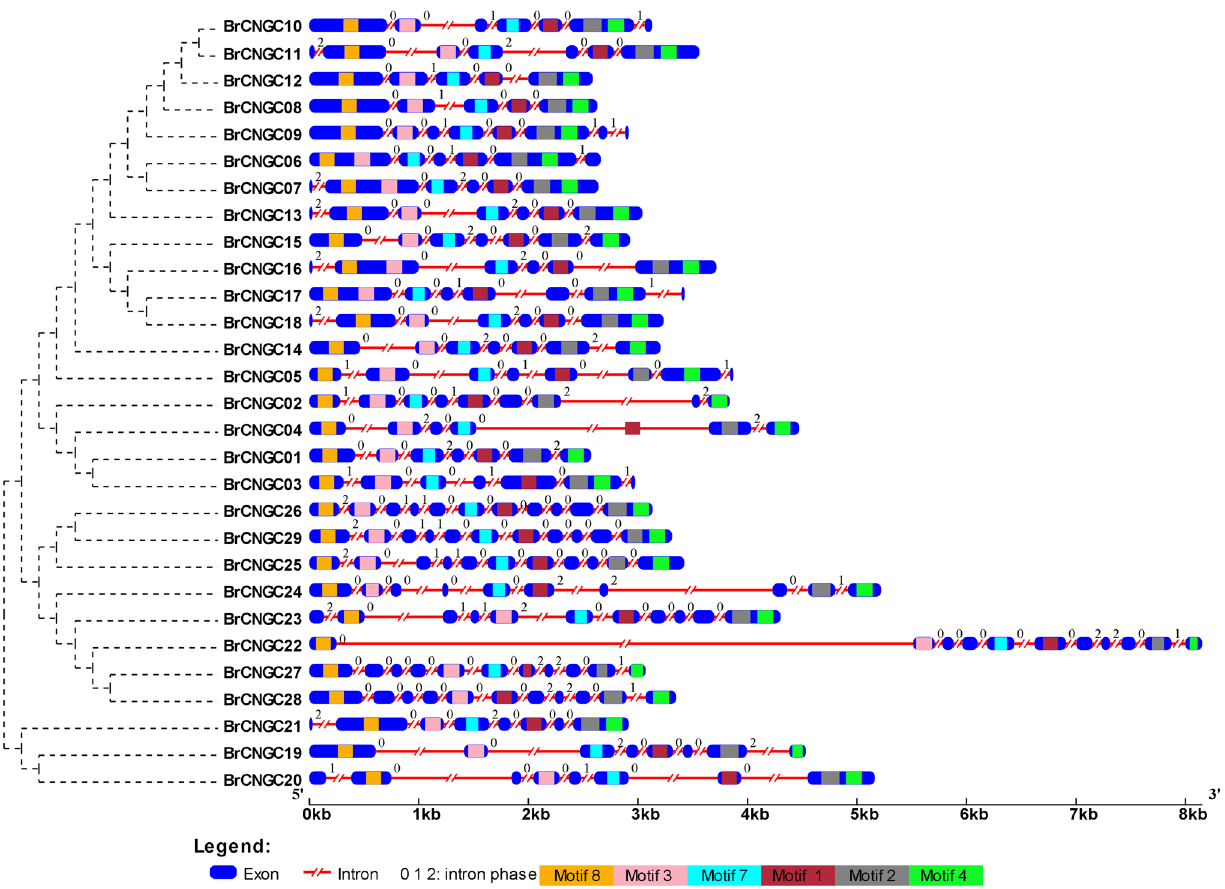
Figure 4. Schematic diagram showing the structures of BrCNGC genes and conserved motifs in their encoded proteins. Exon–intron organization and conserved motifs within the 29 BrCNGCs. The NJ phylogenetic tree of CDs is shown on the left side of the figure, exons-introns indicated as blue boxes and red lines respectively, and motifs are represented by colored boxes within the exons. Numbers [0, 1 and 2] given on gene structures represent the respective intron phases. The lengths of each exon and intron can be mapped to the scale given in the bottom. The order of motifs corresponds to the position of the motifs in protein sequence, however, the length of the boxes does not correspond to the lengths of